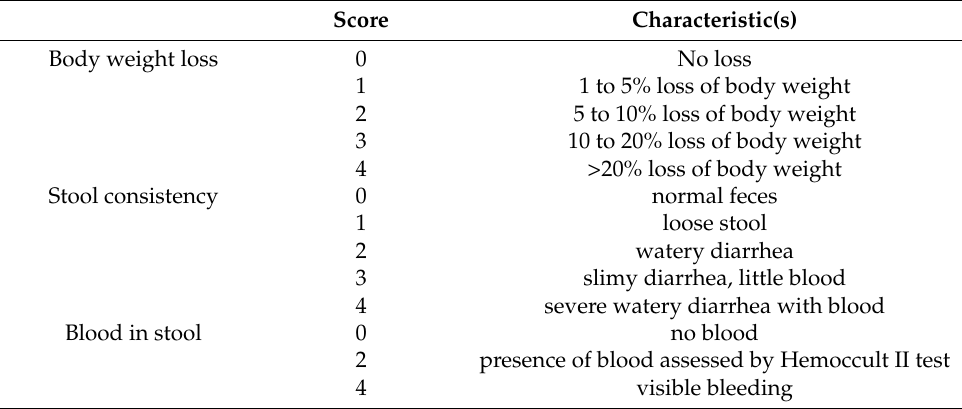
Table 2. Disease activity index (DAI)